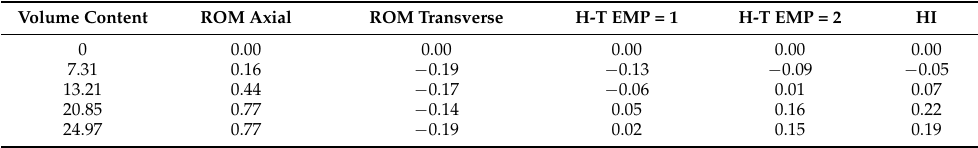
Table 6. Correlation between micromechanical data with experimental data for single jute composite.